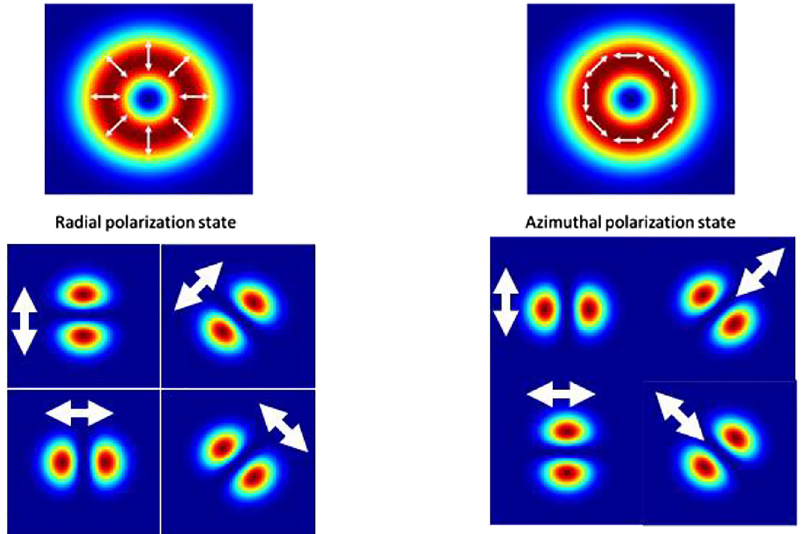
Figure 1: Calculated intensity distribution of beams with radial and azimuthal polarization states (top) together with the recorded intensity distribution transmitted throughapolarizationanalyzerwithitsaxis oriented at 0 ° , + / − 45 ° and 90 °